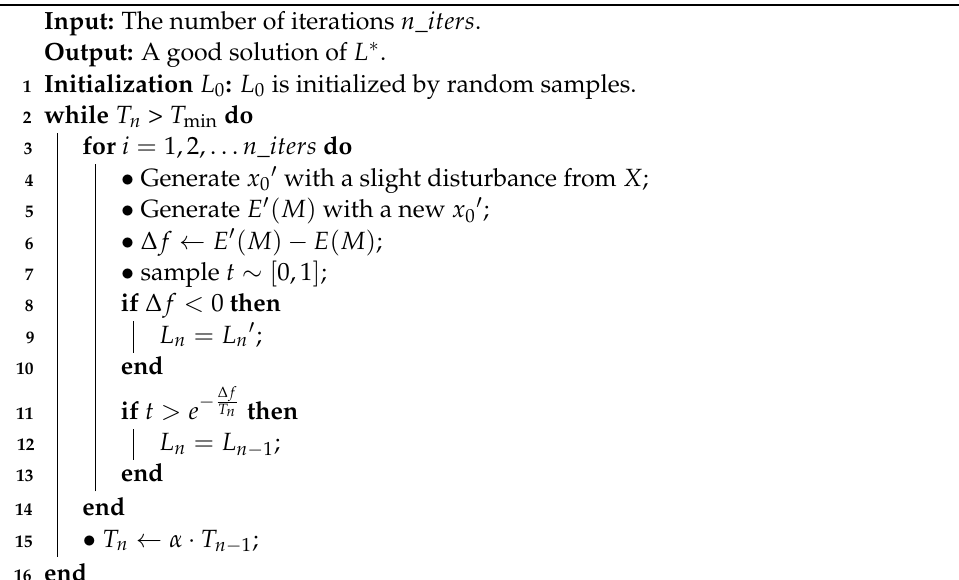
Algorithm 1: Procedure of